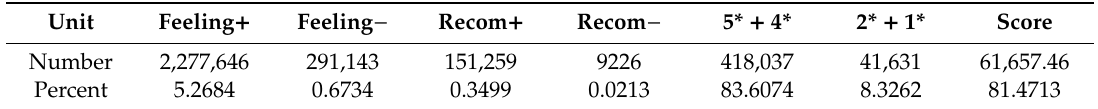
Table 10. Summary of sentiment